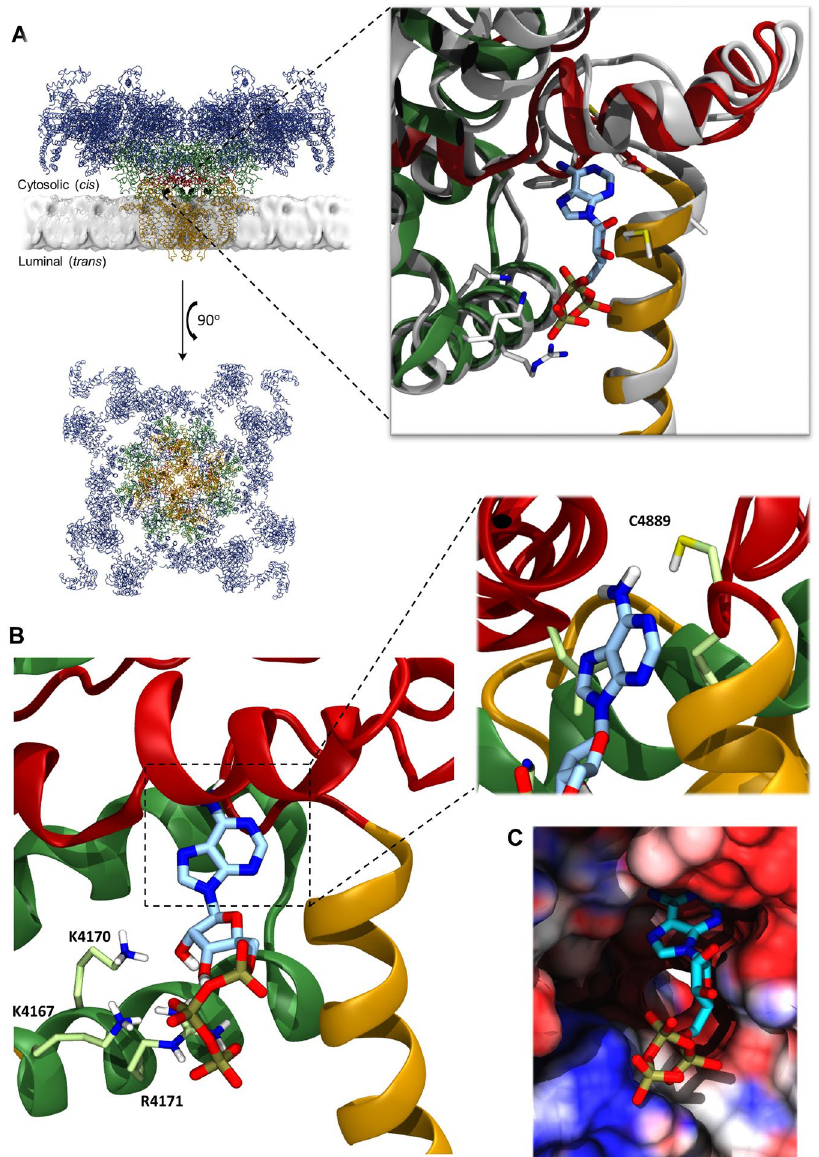
Figure 1. Comparison of RyR1 and RyR2 at the ATP binding site illustrating key residues for interaction with the ATP molecule. ( A ) The overall structure of RyR2 (PDB-ID 5GOA) is depicted in cartoon representation, both in the lipid bilayer and from above 16 . The membrane position was taken from the Orientations of Proteins in Membranes database 38 . Residues 1–3636 are shown in blue, 3636–4207 in green, 4480–4888 (transmembrane domain) in orange and 4889–4967 (CTD region) in dark red. The suggested ATP binding site in each chain is indicated by four black dots and the inset to the right shows a magnification of one of these sites. Each identical ATP site (inset) consists of a fairly hydrophobic pocket, and a more exposed region lined by positively charged lysine and arginine residues. RyR1 (PDB-ID 5TAS) is shown in grey cartoon representation, with important residues indicated and with ATP in the binding site. RyR2, coloured as above, is overlaid for comparison to illustrate the close similarity with RyR1 at this site. ( B ) The RyR2 ATP site is further expanded to show the Autodock-predicted pose for ATP which is most similar to the ATP binding mode observed in the RyR1 cryo-EM structure; important residues are indicated. The inset shows an enlarged view of the adenine region with the C4889 residue shown. ( C ) The RyR1 (PDB-ID 5TAS) ATP site shown in surface representation with an ATP molecule bound. The surface is coloured by the electrostatic potential, going from dark blue (most positive), through white (neutral) to red